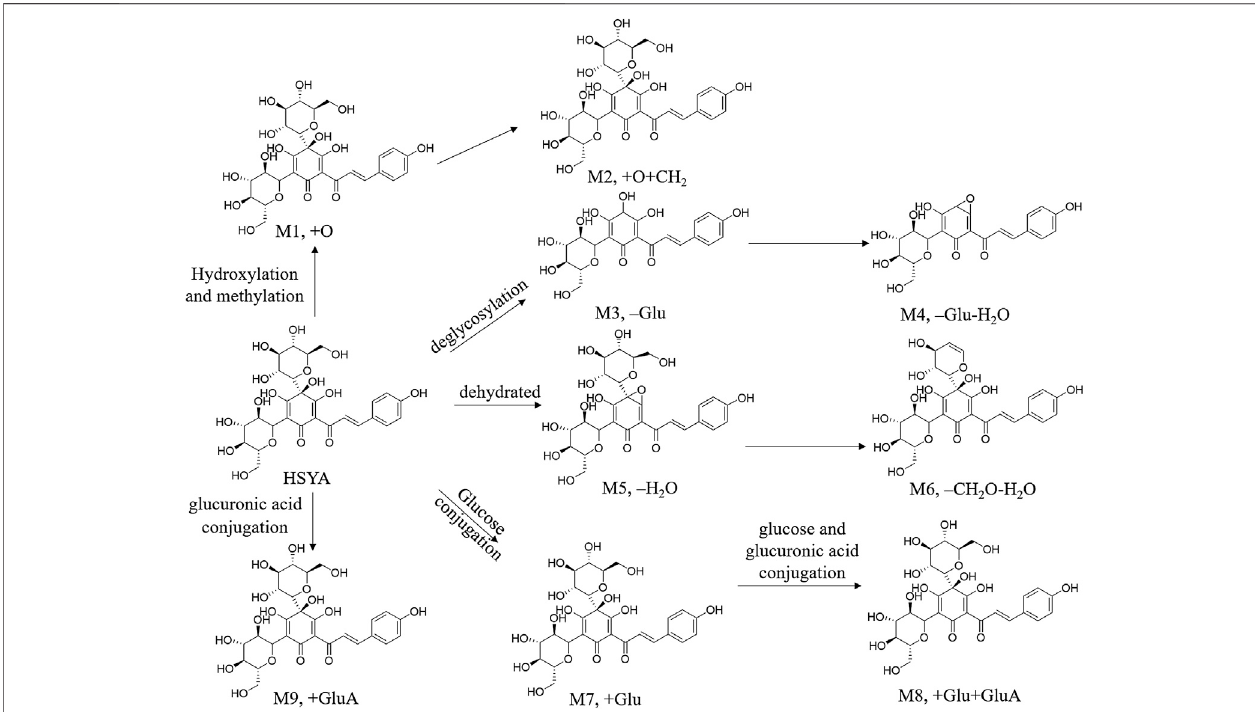
FIGURE 6 | Proposed metabolic pathways of HSYA (Jin et al., 2016; Wu et al., 2018).